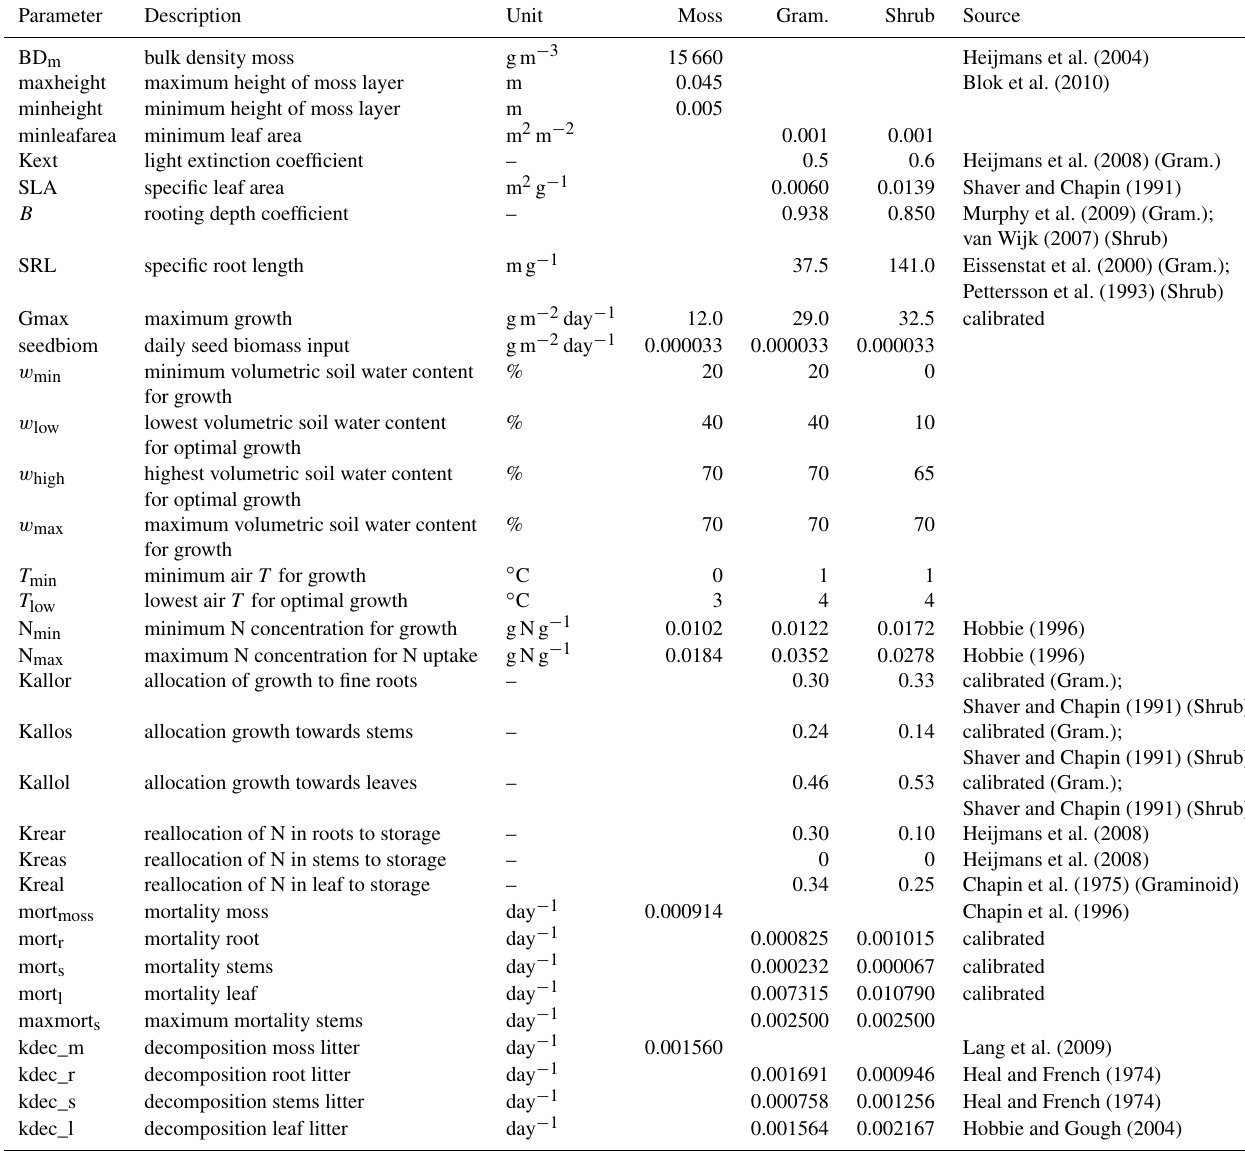
Table A1. Plant functional type parameter values in